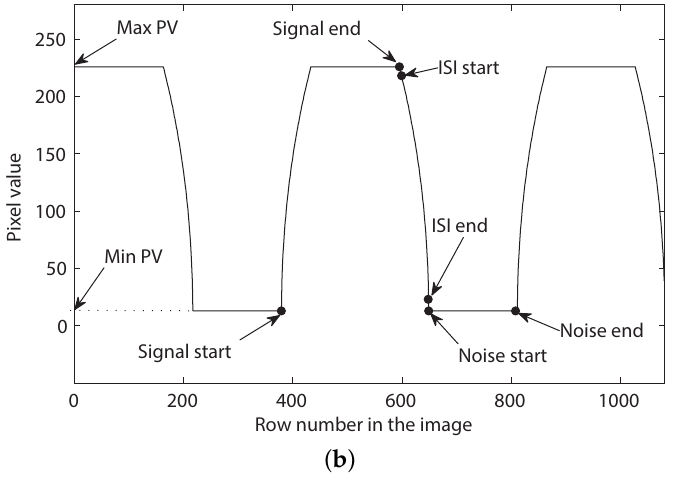
Figure 10. Simulated image and method for calculating SINR. ( a ) Simulated image; ( b ) Pixel value in each row of the simulated image.